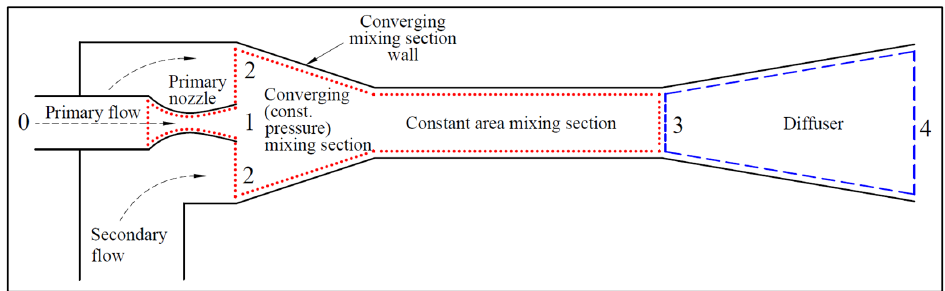
Figure 12. The dotted (red) and dashed (blue) lines are showing control volumes D and E,